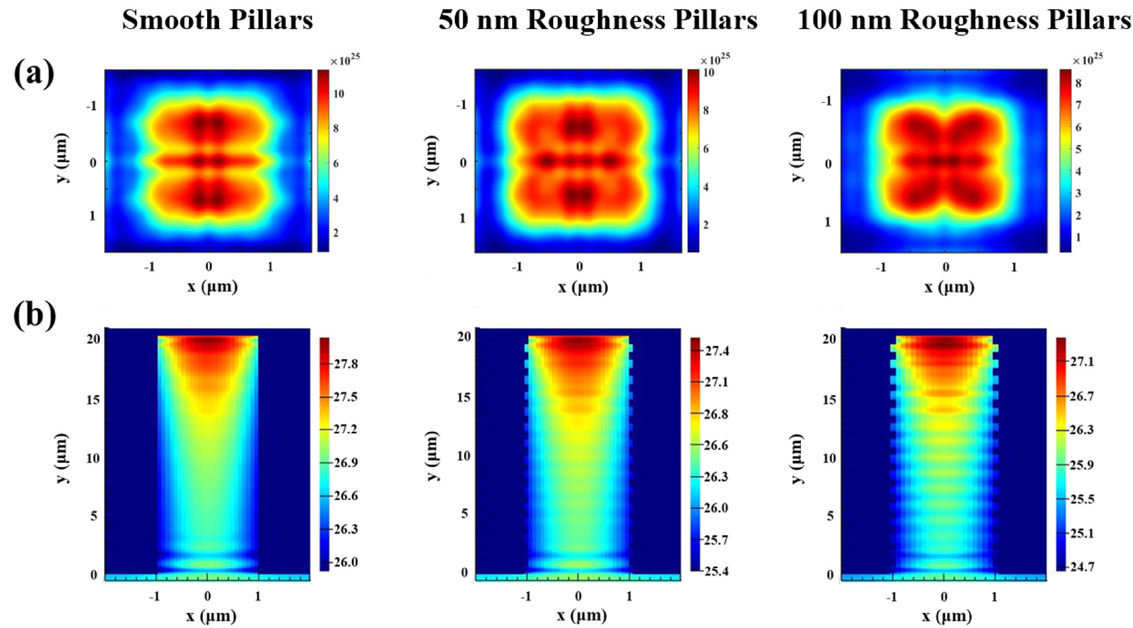
Figure 5. ( a ) Exciton generation rate distributions at the top of micropillars with different roughness at wavelengths of 400–1100 nm. ( b ) Energy generation rate distributions of micropillars with different roughness respectively at wavelengths of 400–1100 nm. The period of the micropillar is 4 µ m, and the width is 2 µ m.